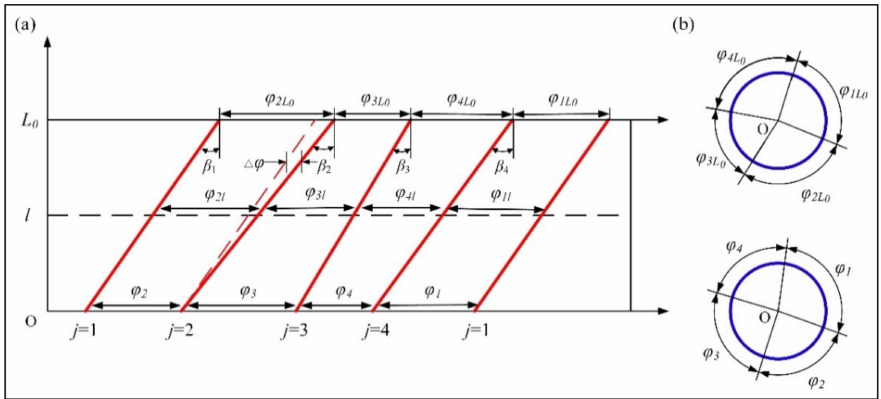
Figure 5. Expanded diagram of the cutting edge for unequal-pitch end mill: ( a ) axial expansion of cutting edge; ( b ) radial distribution of pitch